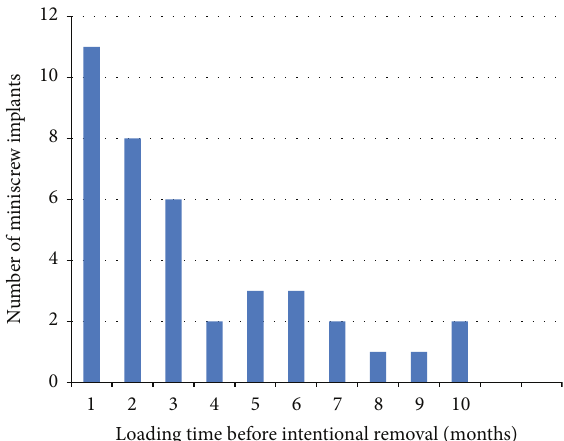
Figure 1: Loading time of successful miniscrew implants removed intentionally.